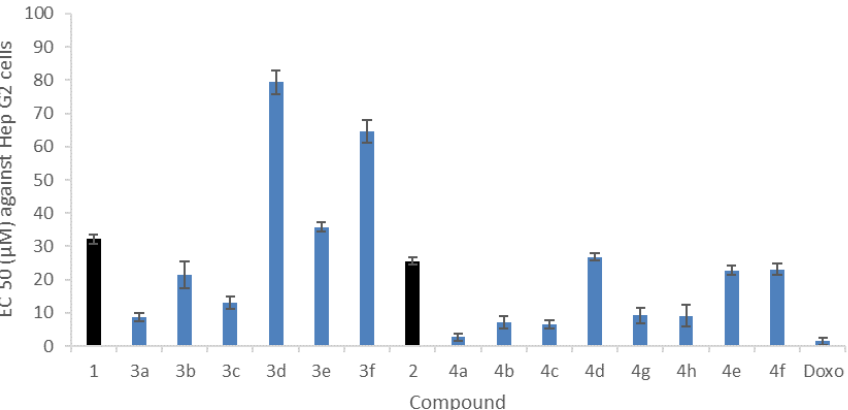
Figure 3. EC 50 values for the cytotoxicity of compounds 1 , 2 , 3a–f , 4a–f , and Doxo . EC 50 values were calculated using Graph Pad Prism and expressed as the mean ± SD.